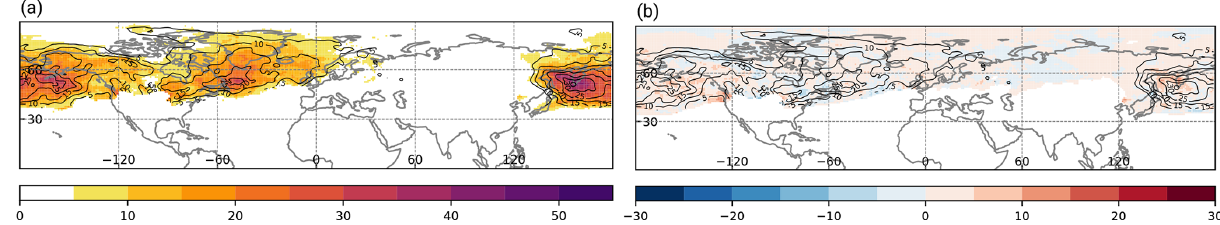
Figure 2. (a) Climatological matching frequency of blocking anticyclones and WCB outflow footprints during DJF as identified with the trajectory-based approach (black contours in %) and the CNN-based approach (shading in %). (b) Contours as in (a) , but shading denotes the difference in matching frequency (in %) between the CNN-based and trajectory-based approach.